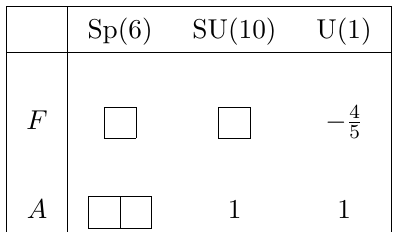
Table 1 . Matter content in UV (above con(cid:12)nement scale